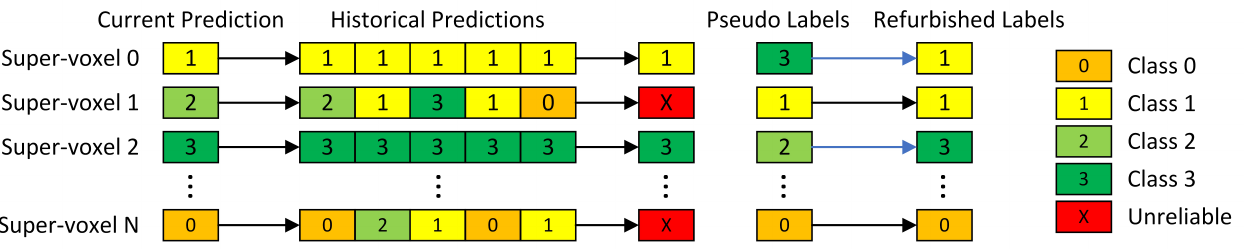
Figure 4. Illustration of the history-guided label refurbishment (HLR) module. We use a historical queue to store the past predictions and correct the previously generated pseudo-labels with consis- tently predicted classes while keeping the unreliable samples unchanged instead of directly dropping them. Compared with other methods, we take a more conservative strategy, as regularization decreases the overfitting